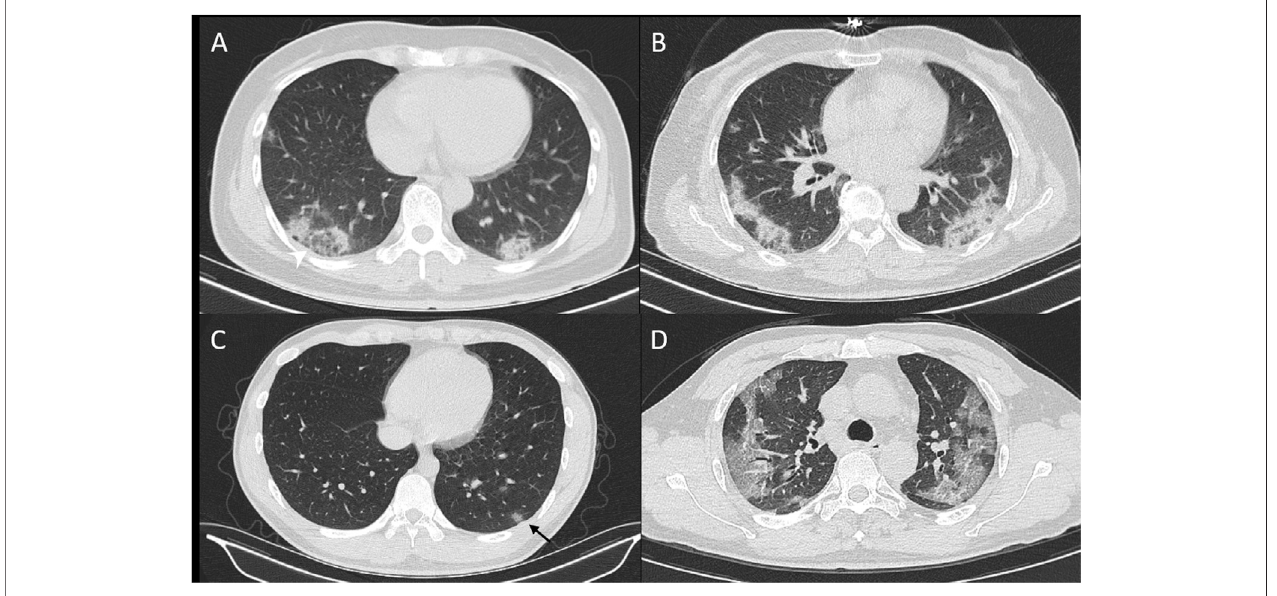
FIGURE 1 | CT signs of reversed hollow sign (A), bilateral distribution of lesion (B), and nodule with hollow sign (C) , and crazy-paving sign (D)